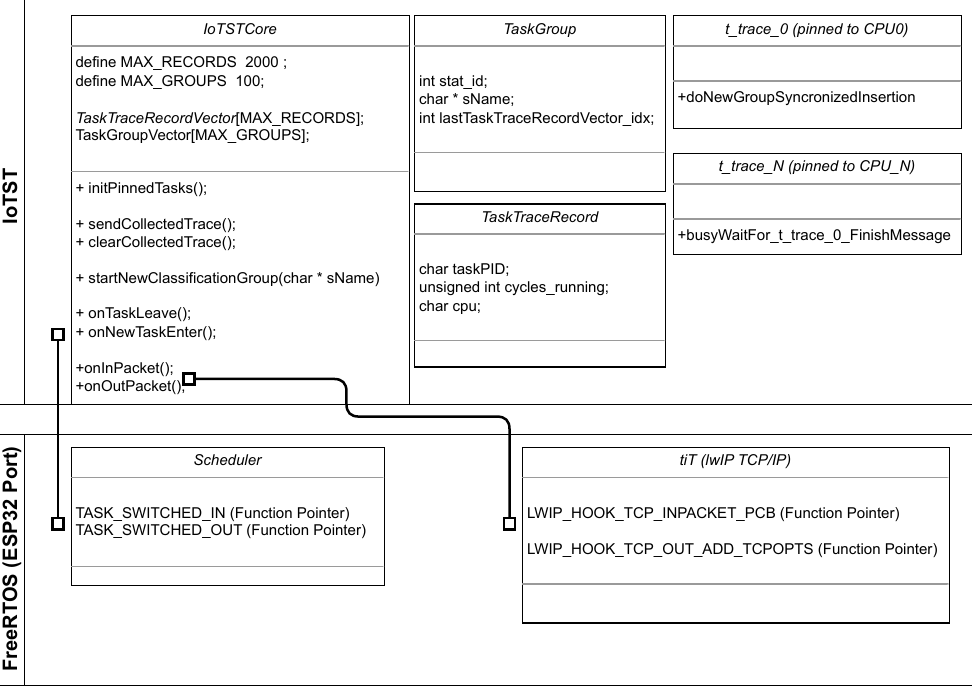
Figure 5. Relevant C code’s organization. The lines between IoTST and the RTOS packages indicate the functions linked during compilation.